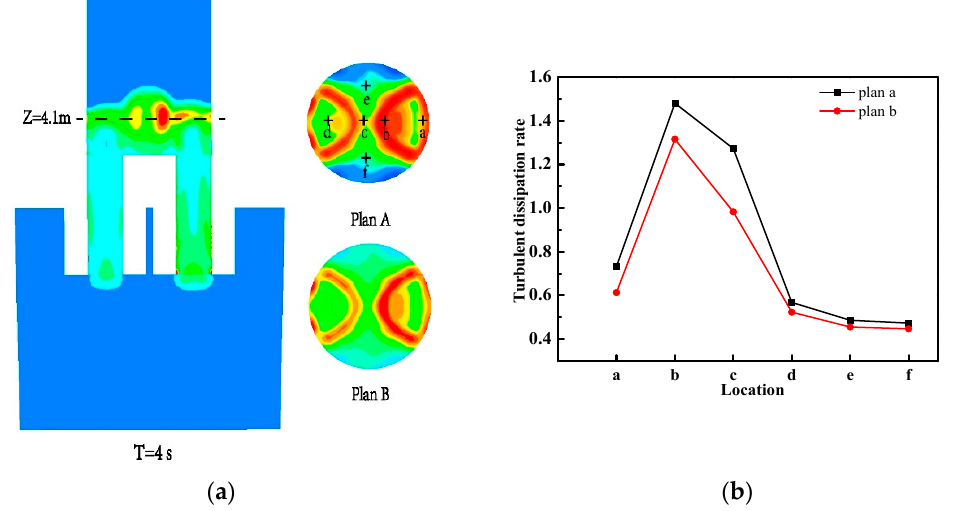
Figure 7. ( a ) Turbulent kinetic energy dissipation rate of vacuum chamber z = 4.1 m cloud; ( b ) turbulent energy dissipation rate distribution at different positions.